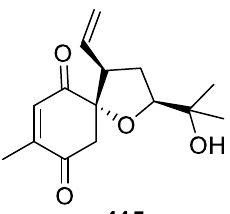
Figure 52. Spirocyclic natural product heliespirone featuring a tetrahydrofurane and a quinone-like moiety.